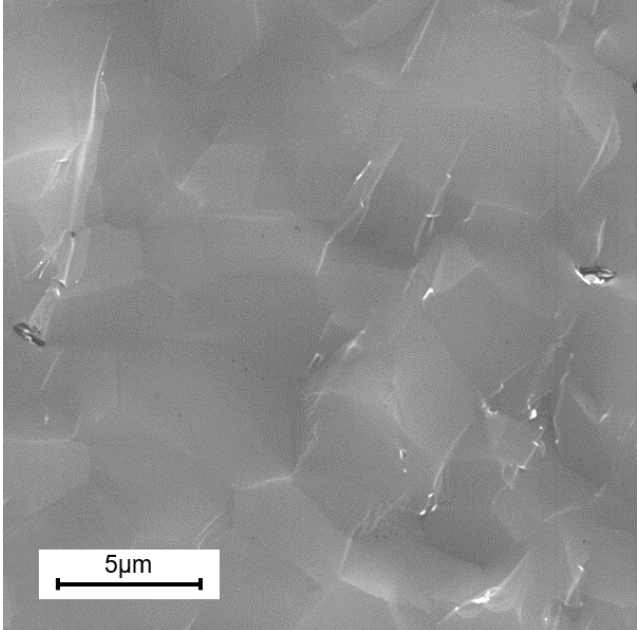
Figure 3. Scanning electron micrograph (SEM) of fracture surface of B 4 C after flexture strength testing. The thermal expansion of B 4 C was almost linear and the average coefficient of thermal expansion was calculated to be equal to 6 × 10 −6 / K in the 25–1000 °C temperature range (Figure 4). The measured